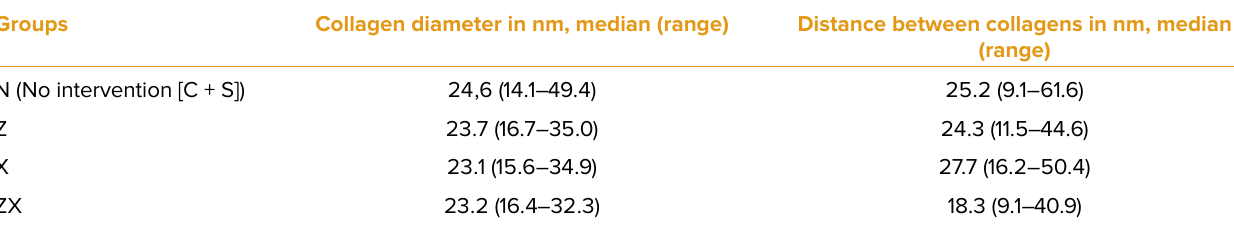
Table 2. Collagen fibril diameter and distance between fibrils regarding the groups which were measured by TEM. Groups Collagen diameter in nm, median (range)